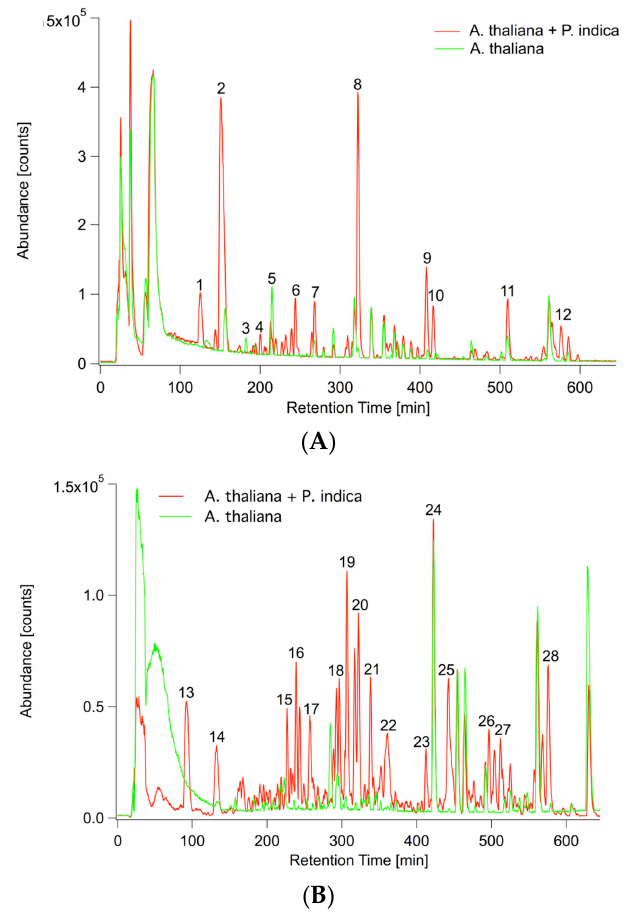
Figure 3. Overlay of representative UPLC/ESI(+/ − )-QTOFMS base peak chromatograms ( m/z 100–1000) of inoculated (red) and non-inoculated (green) A. thaliana exudates. ( A ) ESI(+): positive